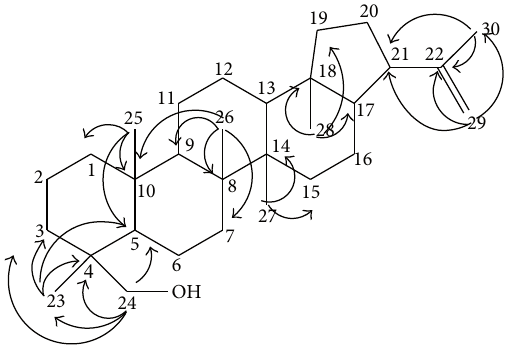
F 1: Key HMBC correlations of compound 2.